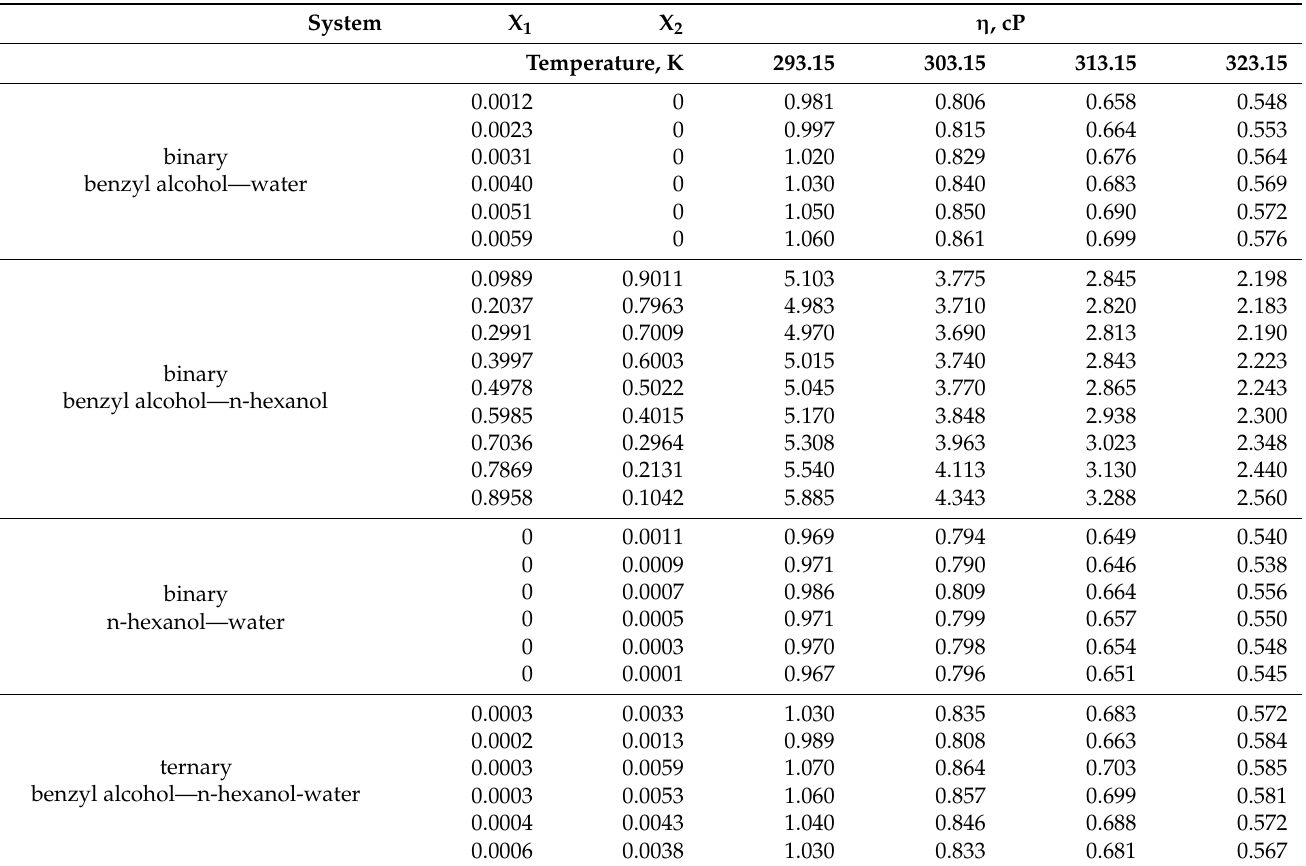
Table 2. Viscosity of binary and ternary mixtures of: benzyl alcohol (1), n-hexanol (2) and water